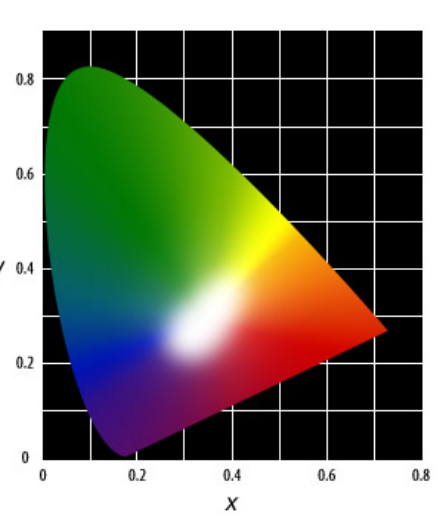
Fig. 1. The tristumulus values XYZ